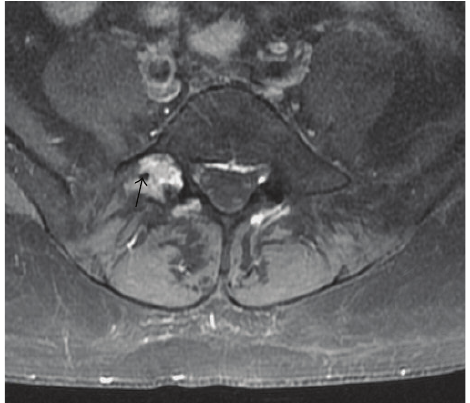
Figure 3: Full length Tru-cut biopsy of the tumor. Note the entrapment of the skeletal muscle and adipose tissue at the periphery (double arrow) and involvement of the bone at the other end (single arrow). (H&E, 40X).